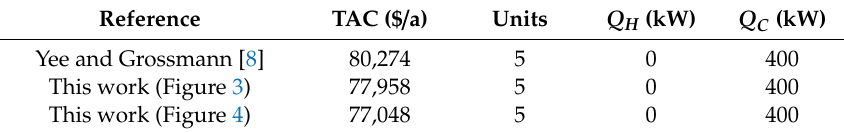
Table 2. Comparison results of case